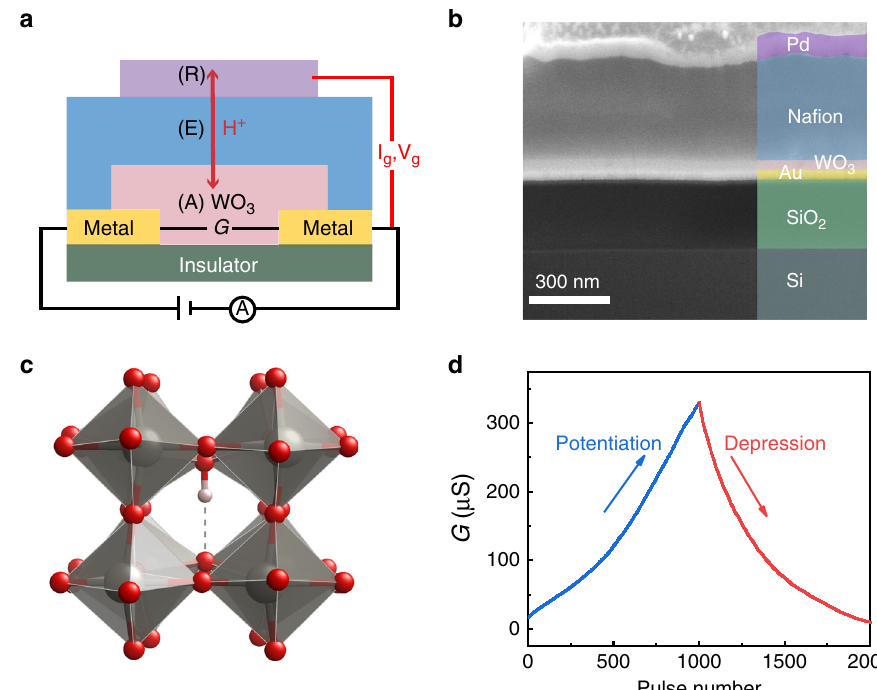
Fig. 1 Device con fi guration and operating principles. a Schematic of the protonic electrochemical synapse device structure. R: solid-state hydrogen reservoir layer, serving also as gate electrode. E: solid-state proton conductive electrolyte layer. A: active switching layer, serving as conducting channel. G refers to the conductance of the channel between the source and drain electrodes (noted as Metal), calculated from G = I d / V ds , where I d is the current measured at the drain and V ds is the reading bias applied between the source and drain. I g , V gs : the gating current and gating voltage, applied between the gate and the source. b Scanning electron microscopy image of the device cross-section. c WO 3 lattice indicating the sites that allow proton intercalation and the bonding between the proton (white sphere) and the oxygen ions (red spheres). The grey spheres are Tungsten atoms. d Demonstration of potentiation/depression behavior of the electrochemical synapse by signals of + 200nA/ − 200nA and 5ms; potentiation and depression represent the synaptic strengthening and weakening behavior. Each data point represents the average conductance value of the steady states measured after each gating